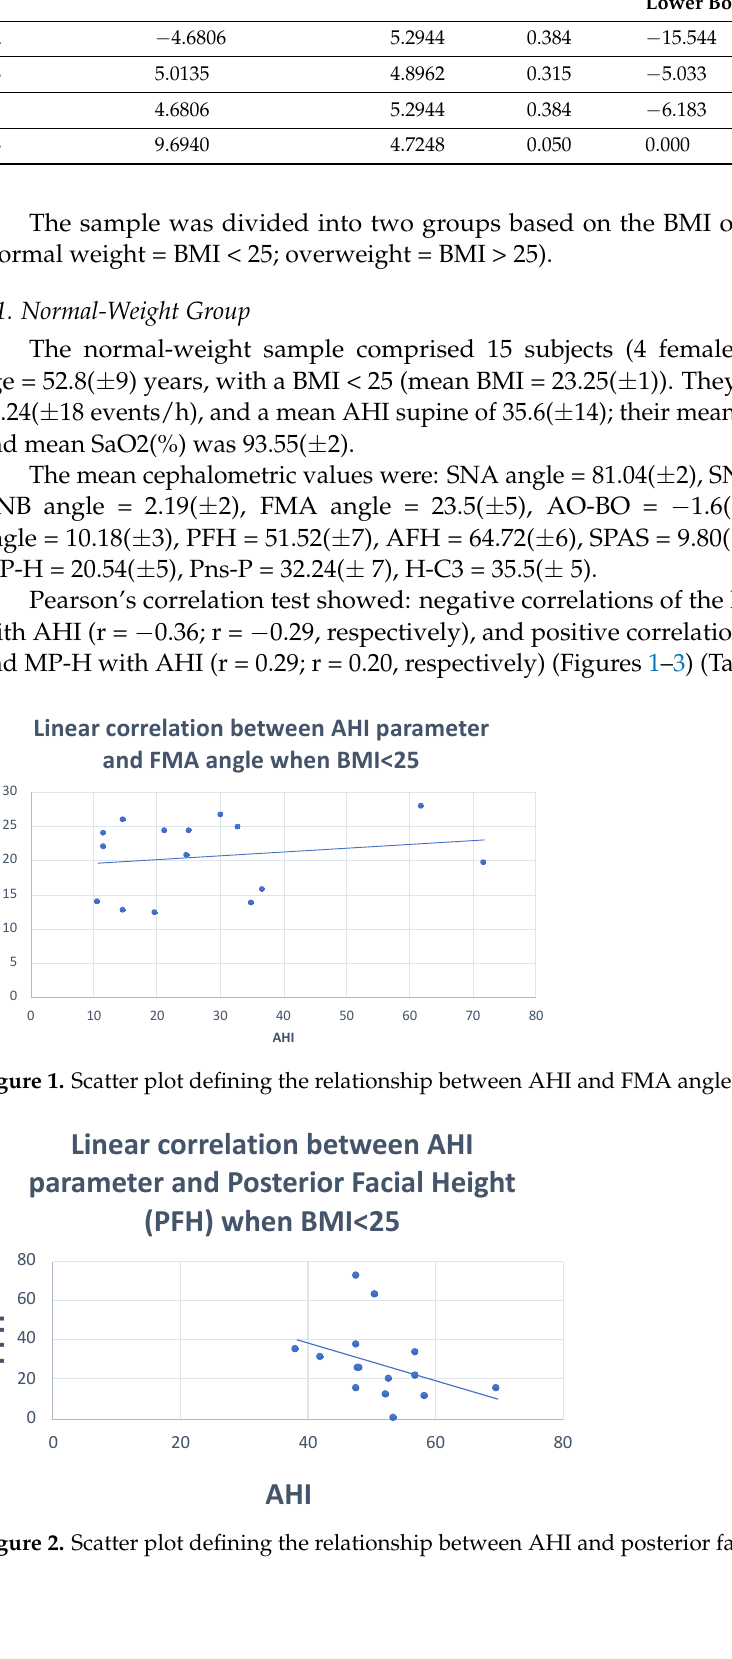
Figure 3. Scatter plot defining the relationship between AHI and MP ‐ H distance. r = 0.29. Table 5. Pearson correlation analysis between cephalometric variables and OSA parameters (AHI, AHI supine) in the normal ‐ weight group (BMI < 25).